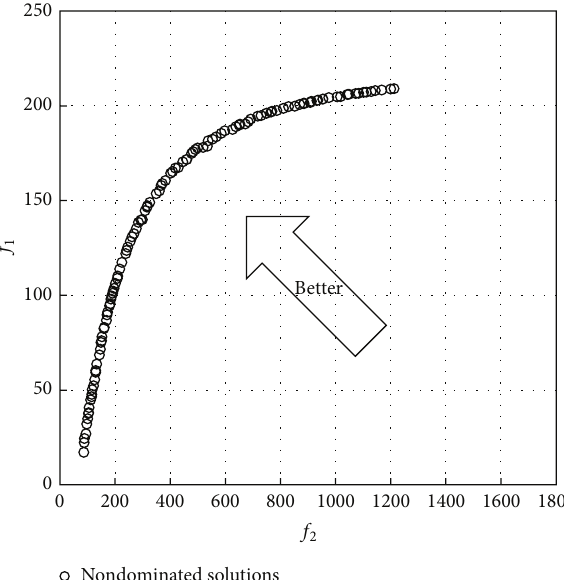
Figure 12: Nondominated solution set of hybrid rocket engine design